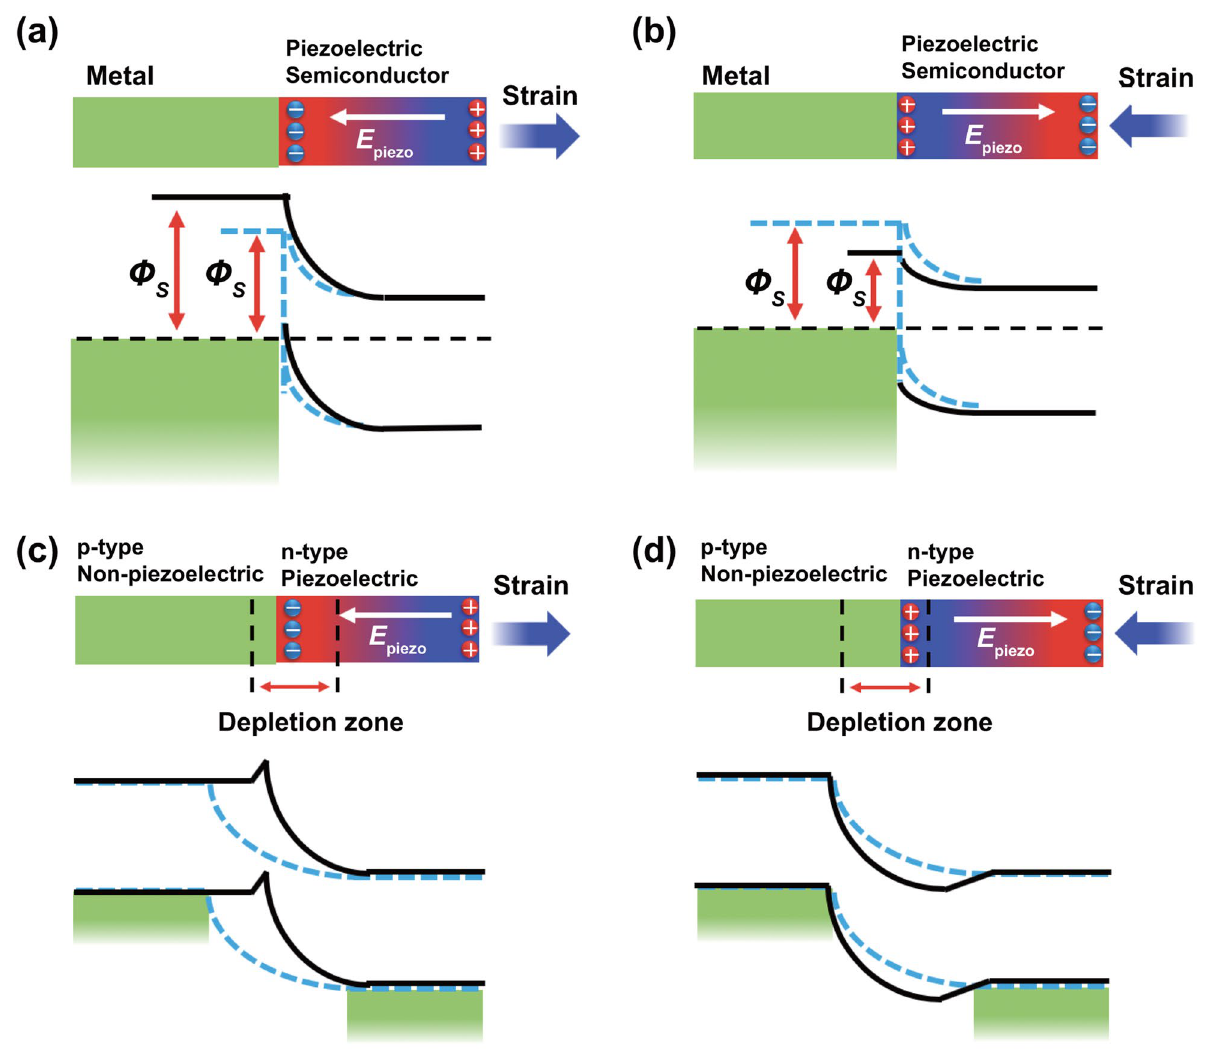
Fig. 2 Schematic for illustrating the modulation of photoelectric device based on 2D piezoelectric semiconductors. The variation of energy- band profiles and carrier distribution of a Schottky contact induced by tensile strain ( a ) and compressive strain ( b ). The variation of energy-band profiles and carrier distribution of a p – n junction induced by tensile strain ( c ) and compressive strain ( d